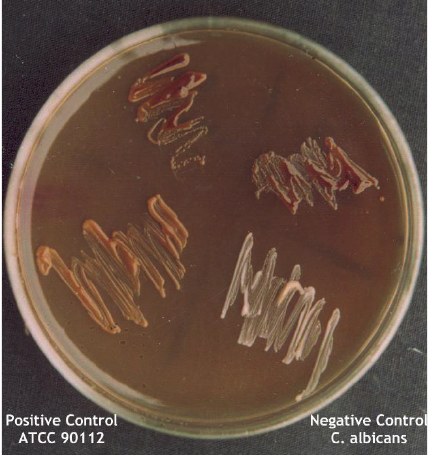
Figure 1: Brown color effect of C. neoformans on Eucalyptus leaves agar media; white colonies of C. albicans negative control and brown pigmented colonies of positive control and environmental